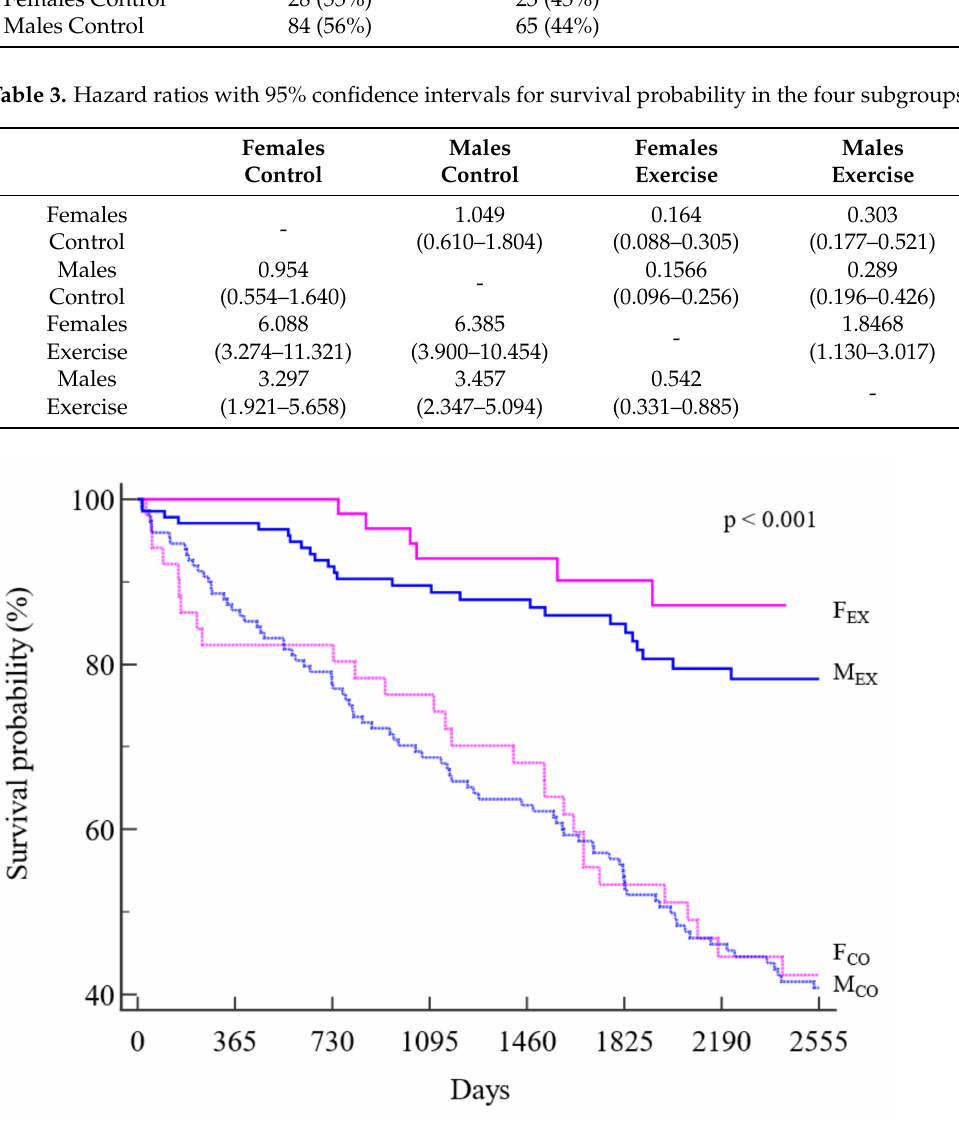
Figure 1. Kaplan-Meier survival curves of survival in the four subgroups. Legend: dotted lines: control group; straight lines: exercise group; pink: females; blue: